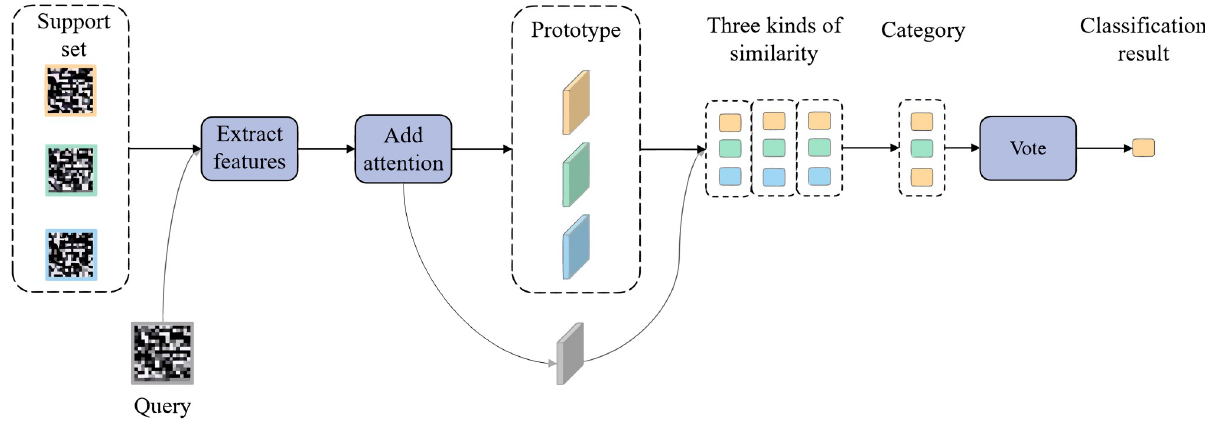
Fig 7. Proposed classification